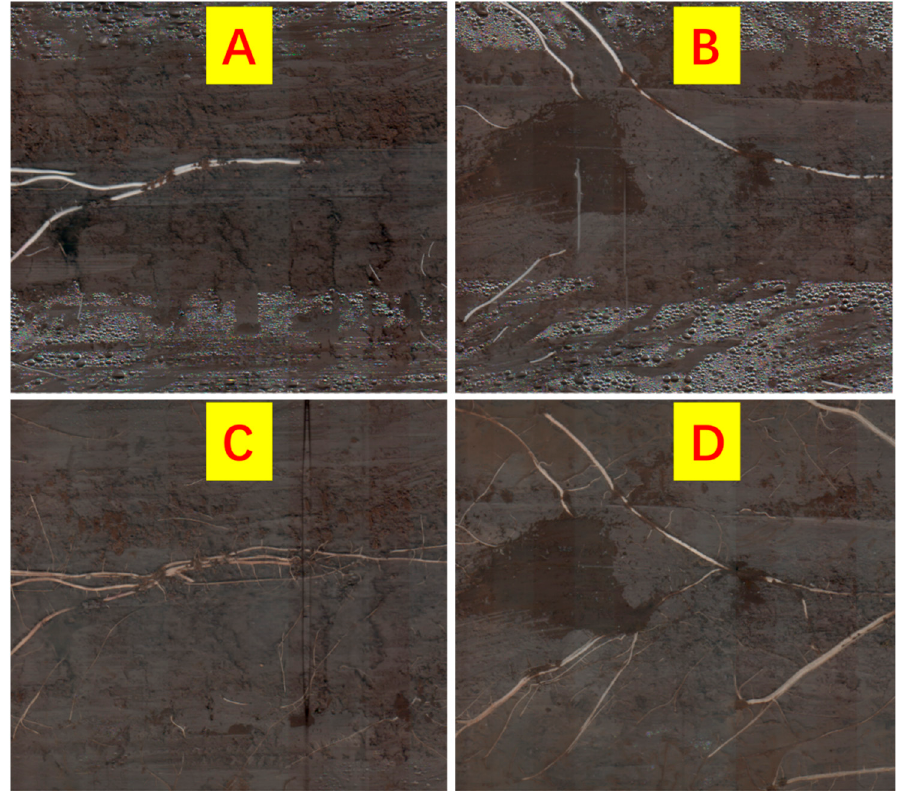
Figure 2. Root morphology difference of the micro-root window between the carbon-based fertilizer and the chemical fertilizer treatment at different sampling dates (taking Jingke 968 as an example). Note: ( A , C ) show the local root morphology on 8 July and 4 September under the fertilizer treatment, and ( B , D ) show the local root morphology on 8 July and 4 September under the carbon-based fertilizer